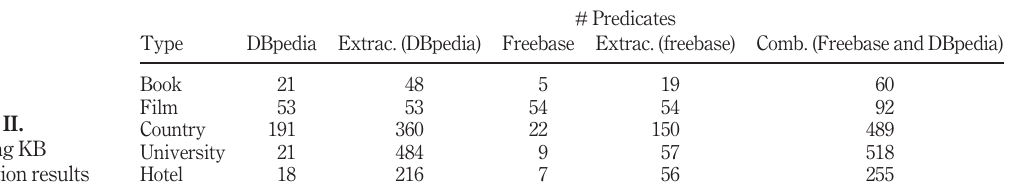
Table I. Entities in the fi ve representative